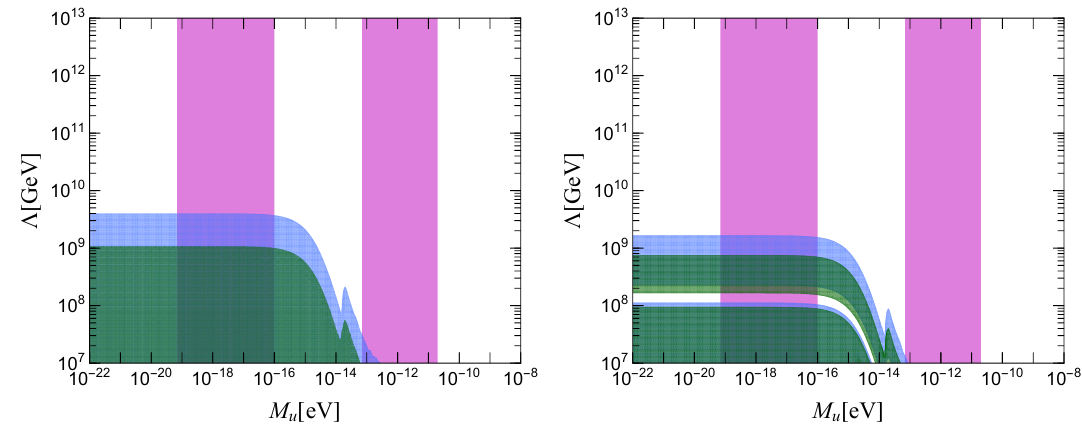
Figure 5 . Exclusion regions in the plane ( M u ; (cid:3)) from the data of (cid:1) m 2 (right panel), see text for explanation. The blue and green areas are for the plus and minus signs in eq. (6.7) respectively. The vertical bands in purple are excluded from black hole